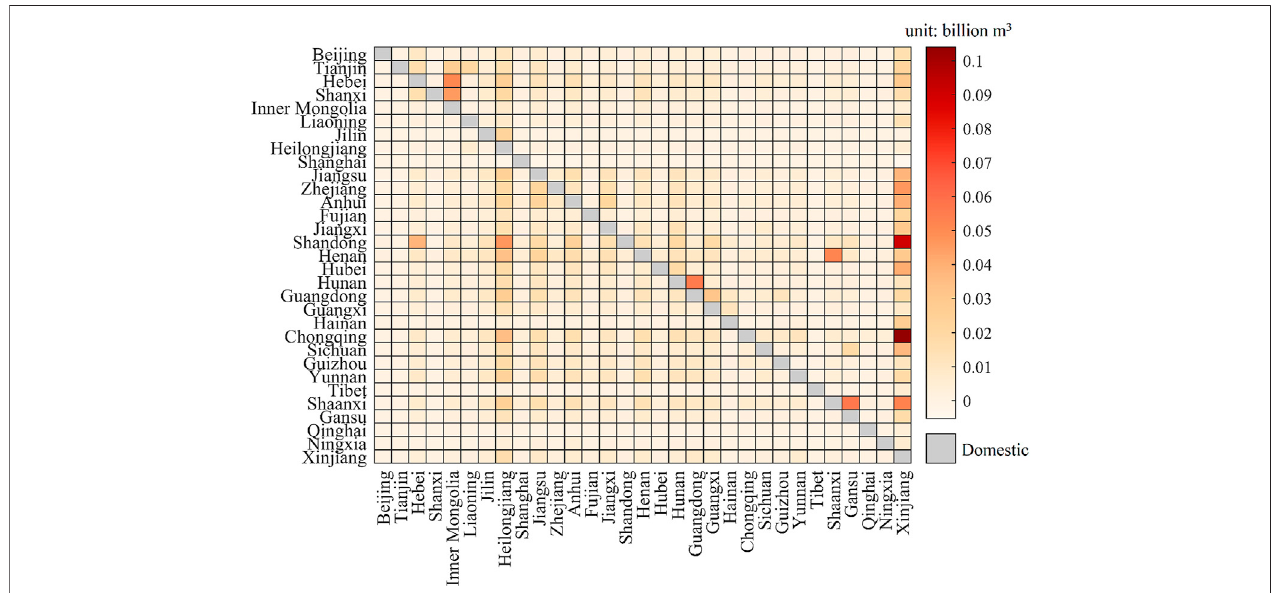
FIGURE 7 | Urbanization effects on the household water footprints of provinces.